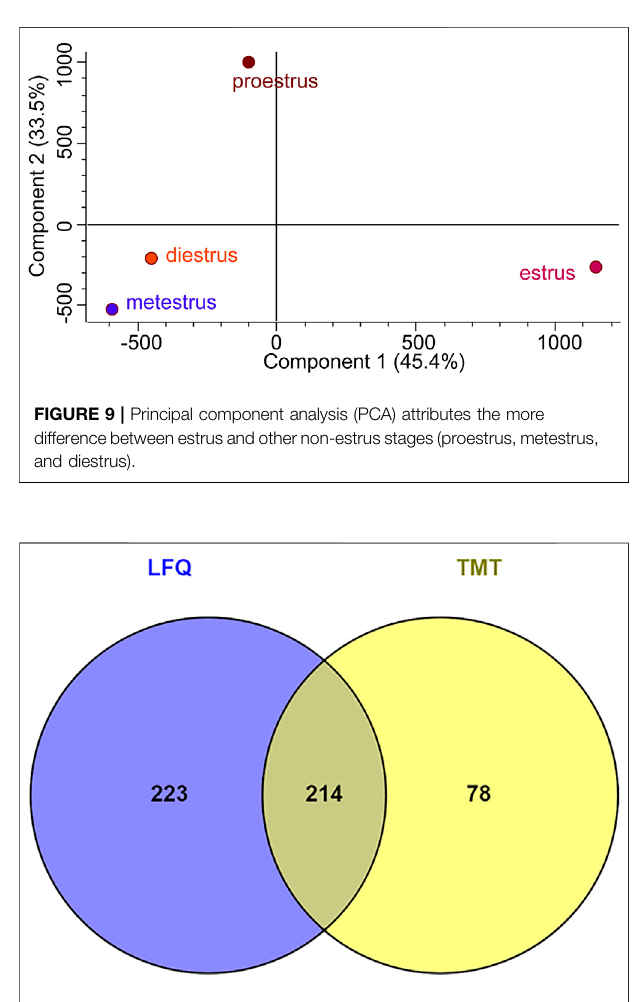
FIGURE 10 | Venn diagram represents number of proteins identi fi ed by tandem mass tag (TMT) and label-free quantitation